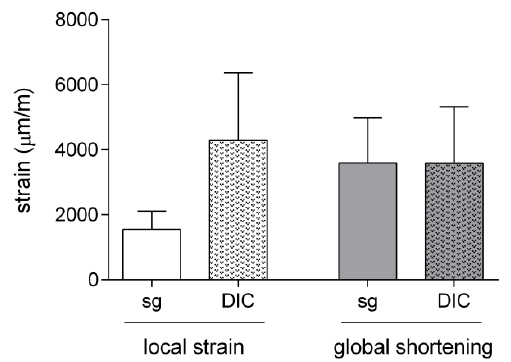
Figure 7. Means ± SDs of the local and global strains measured by strain gauges (sg) and DIC and by the length transducer during the step signal input . n = 5.